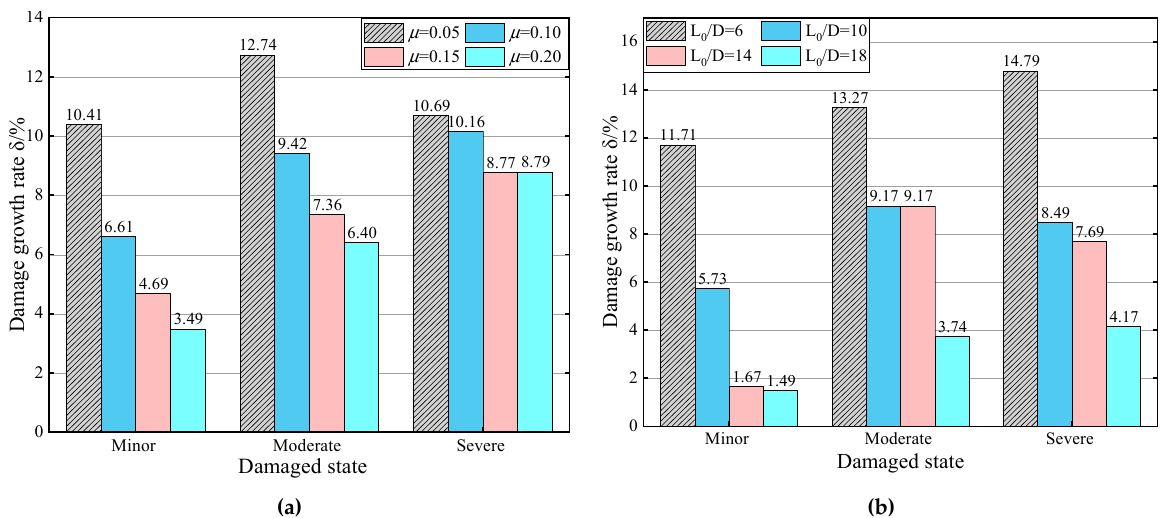
Figure 8. Additional damage: ( a ) different axial compression ratio; ( b ) different shear-span ratio.